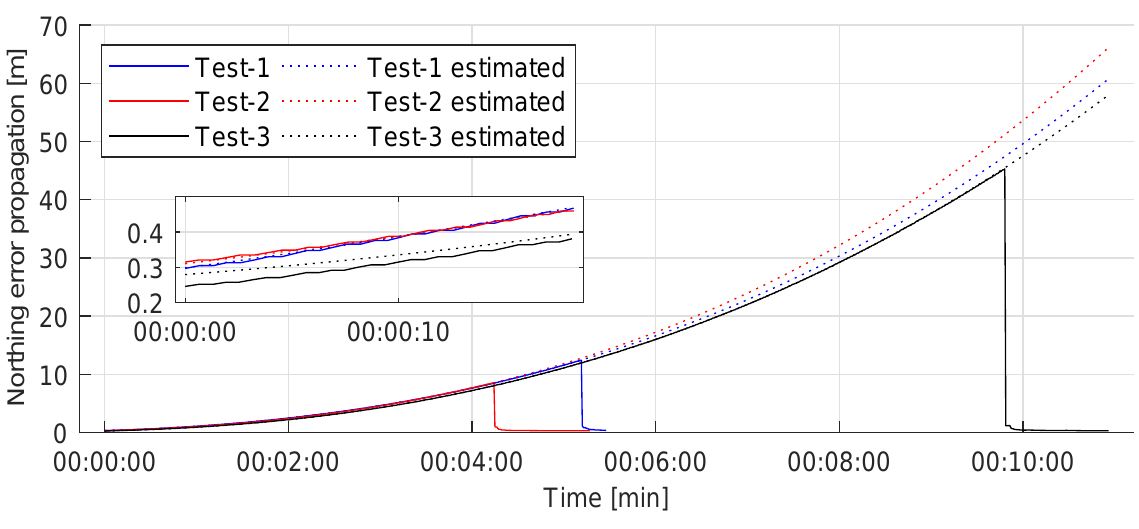
Figure 4. The INS position error propagation in pure inertial